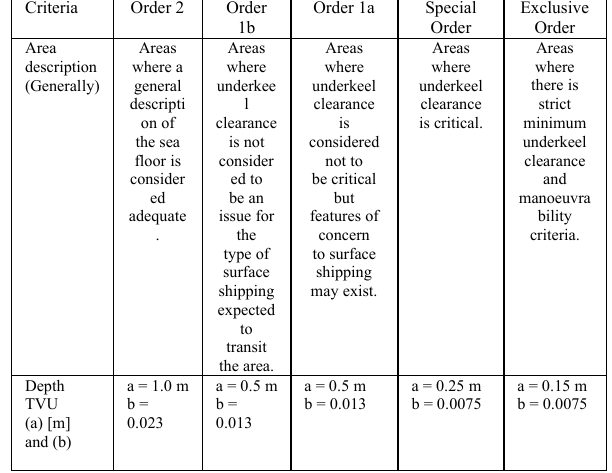
Figure 10. Bathymetric plan relative to the on-site tide gauge in 2018 plotted using AutoCAD Meanwhile, the bathymetric plan (scale 1:12000) for year 2017 reduced relative to the DSMM tide gauge data shows the highest depth of 15.43 metres and the lowest depth of 1.15 metres (Figure 11). Furthermore, the bathymetric plan (scale of 1:12000) for year 2018 reduced relative to the DSMM tide gauge data shows the highest depth of 15.42 metres and the lowest depth of 1.28 metres, as displayed by Figure 12.